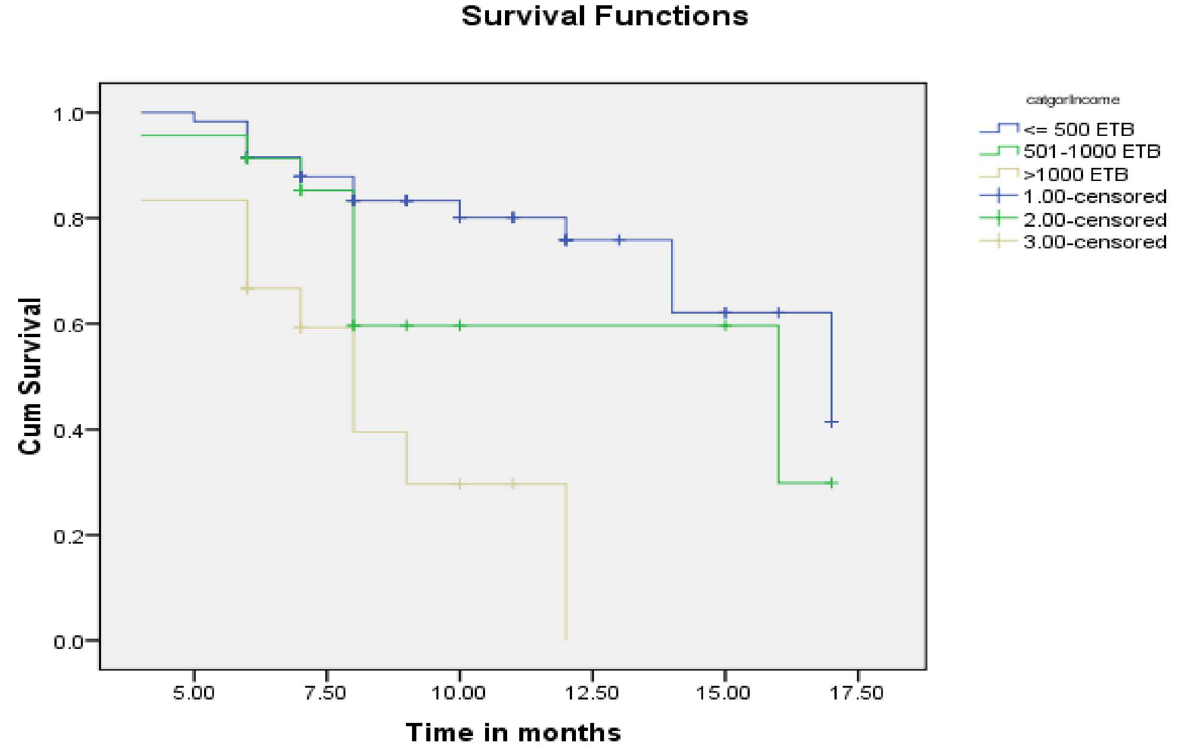
Figure 2. Survival function of breastfeeding duration stratified based on monthly income among HIV positive mothers in Sidama Zone, Southern Ethiopia, 2012.